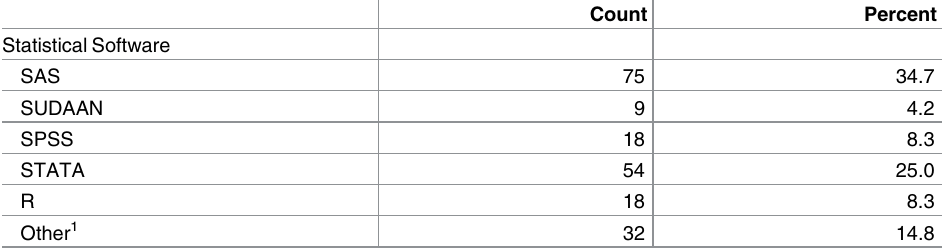
Table 4. Frequency of use reported for statistical software packages (n =